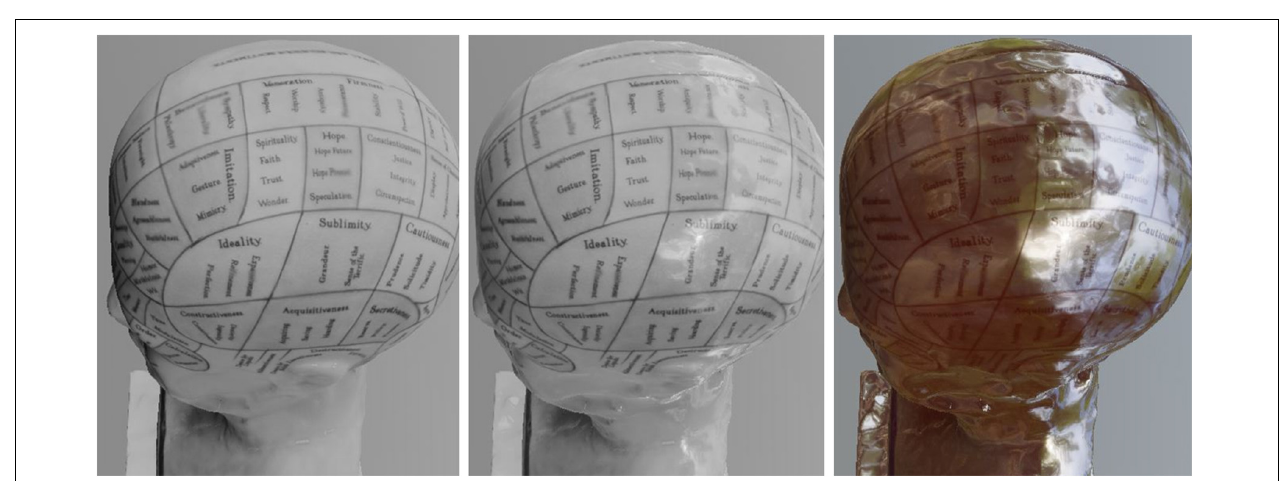
FIGURE 3 | Mapping of the texture (left) to the 3D mesh (right) ; screenshot taken in Blender (Blender Foundation, 2019).